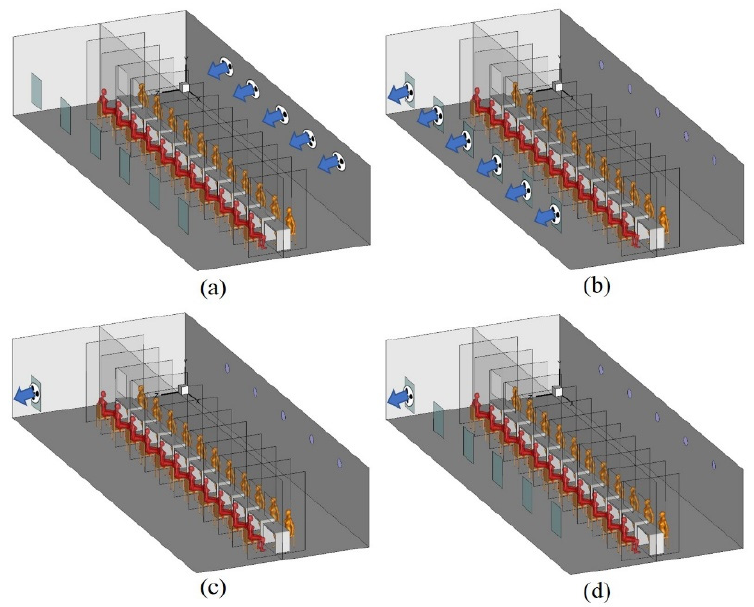
Figure 3. Ventilation strategies for a nasopharyngeal swab sampling cabin: ( a ) MSFV; ( b ) MEFV; ( c ) SEFV; ( d ) SEFV-W.